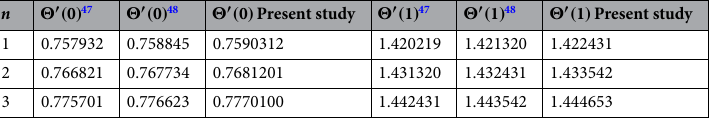
Table 8. Comparison of outcomes of Nusselt number at the disc and cone surfaces respectively and those that of outcomes of other studies 47,48 using only the common parameters.